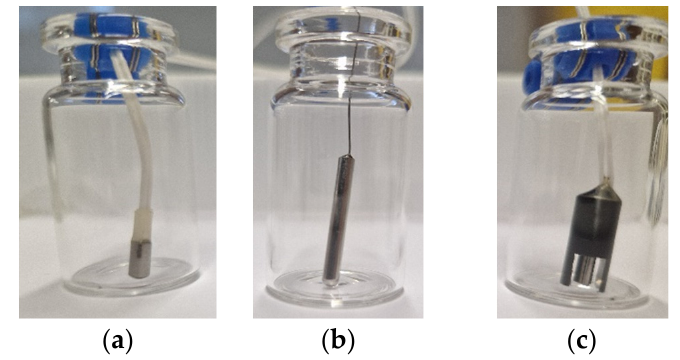
Figure 2. Different temperature sensors in 6R Vials: ( a ) PT100, ( b ) WTMplus, and ( c ) RTD.